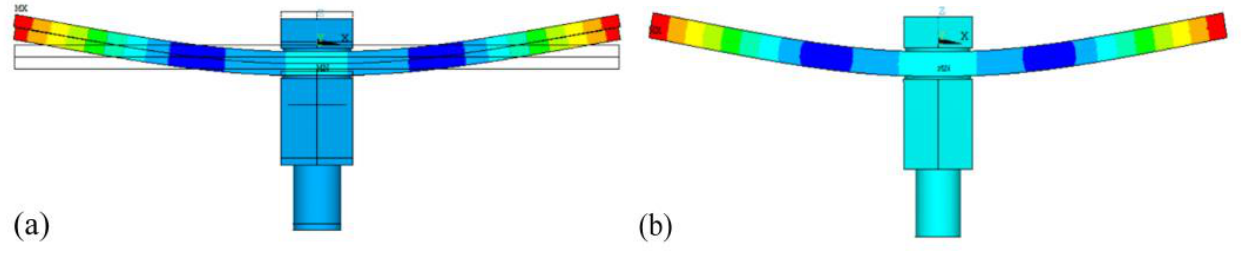
Figure 6. Excited bending modes, ( a ) two-beam joint (472 Hz), ( b ) one monolithic beam (854 Hz)